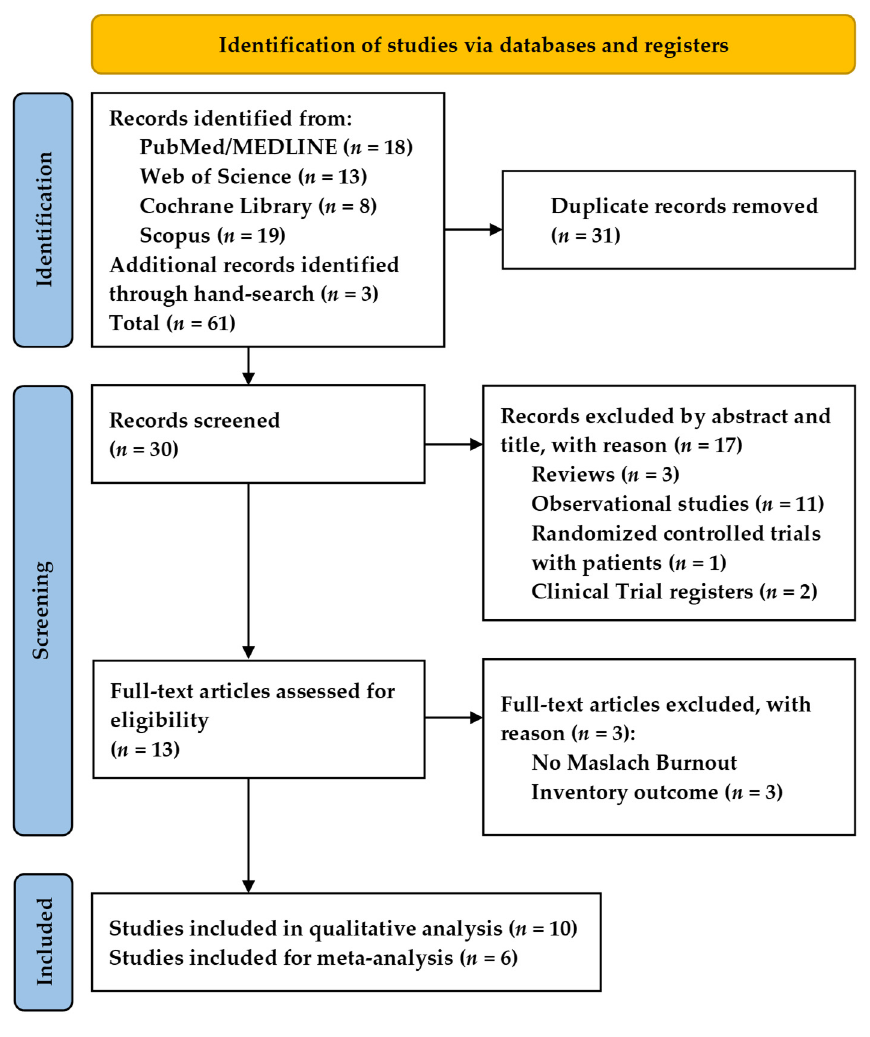
Figure 1. PRISMA flowchart for study inclusion.